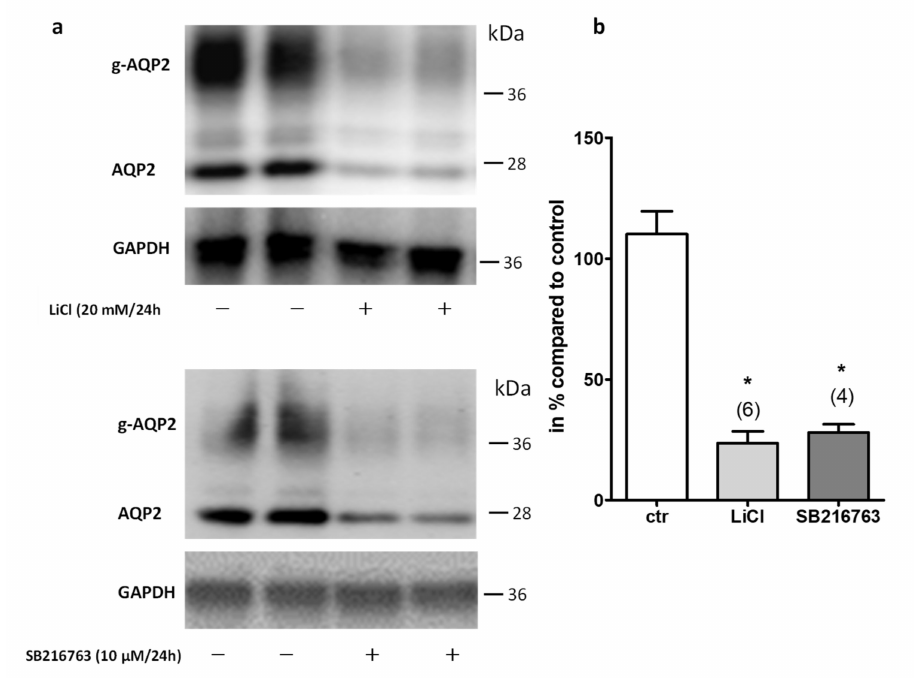
Figure 1. LiCl and GSK3 inhibition reduces Aqp2 expression. The expression of Aqp2 and glycosylated Aqp2 (g-Aqp2) on the protein level in IMCD cells, treated with LiCl (20 mM / 24 h) or the GSK3 α / β inhibitor SB216763 (10 µ M / 24 h), was analyzed by Western blot analysis. In the next step, the membrane was stripped and incubated with an antibody directed against GAPDH ( a ). The signal intensities were densitometrically analyzed and the relative changes in Aqp2 expression compared to untreated cells were calculated using GAPDH for normalization ( b ). One-way ANOVA analysis with Tukey post-test was performed and * indicates statistically significant di ff erences compared to untreated cells ( p ≤